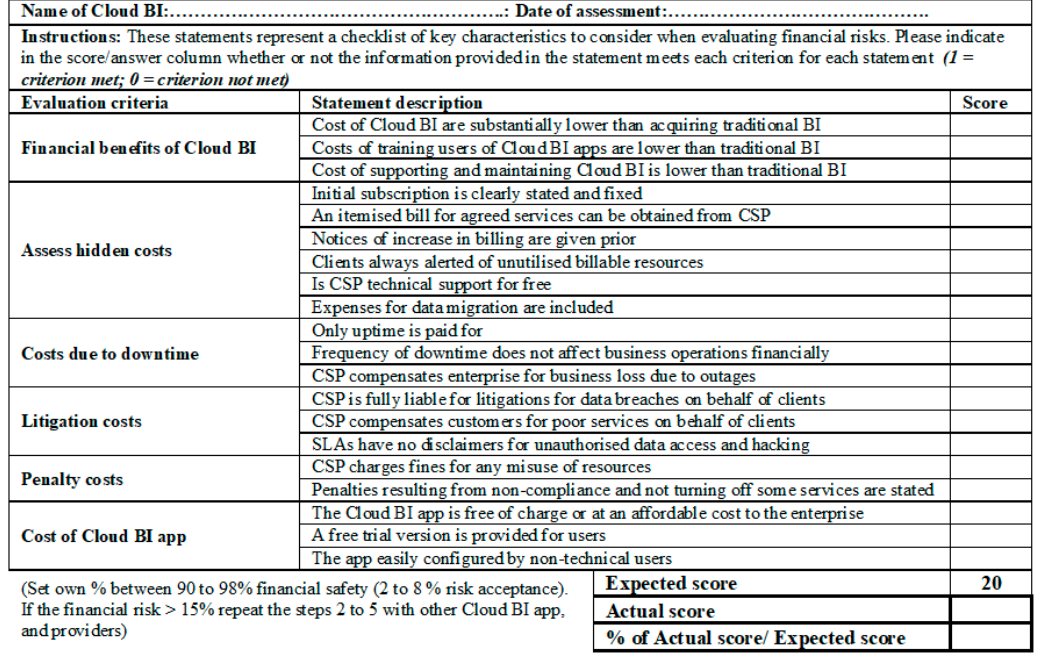
Figure 12. Checklist for assessing financial risks associated with Cloud BI applications.